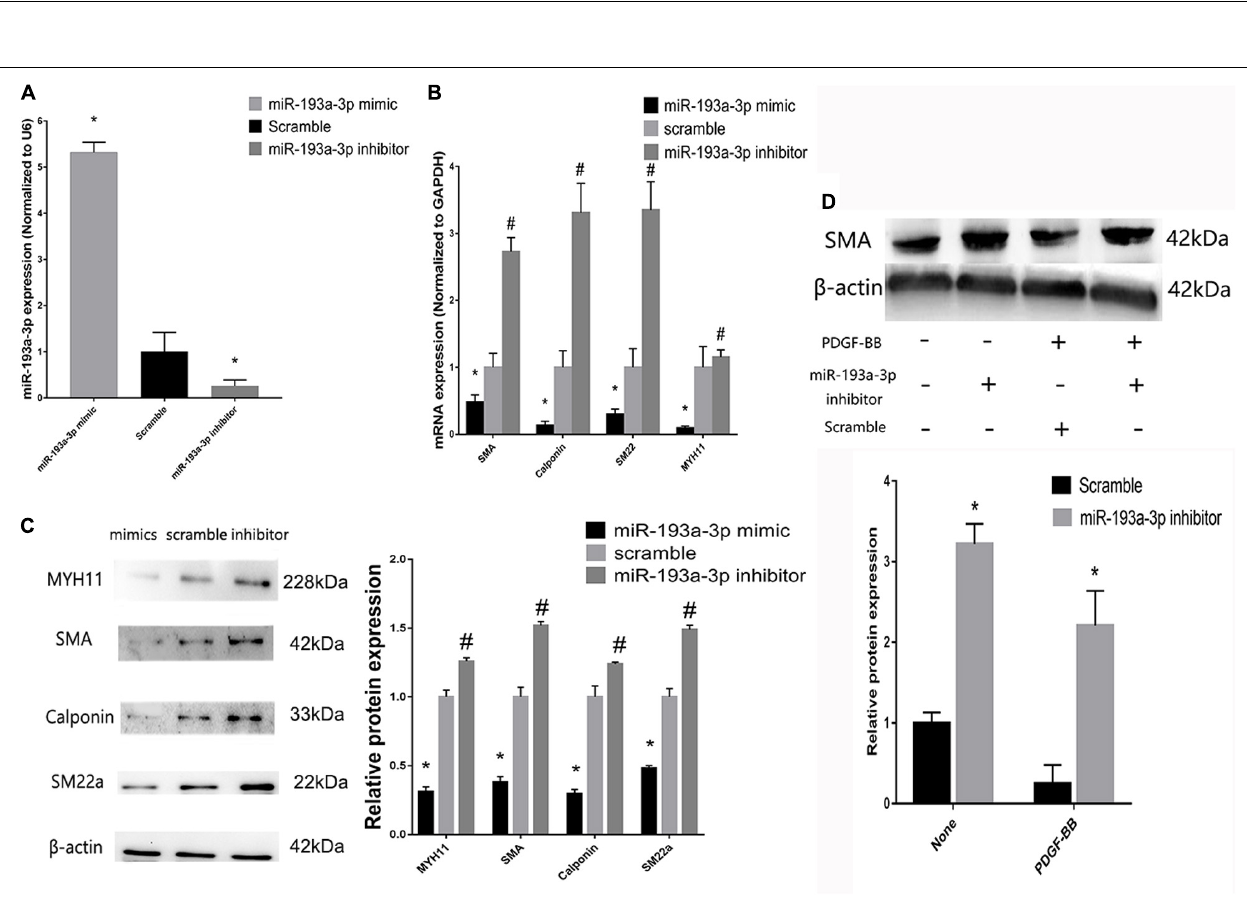
FIGURE 5 | Upregulation of miR-193a-3p in proliferating VSMCs. qRT-PCR showed the time-dependent increase of miR-193a-3p in VSMCs ( n = 5). * P < 0.05 compared to the 24 h cells.